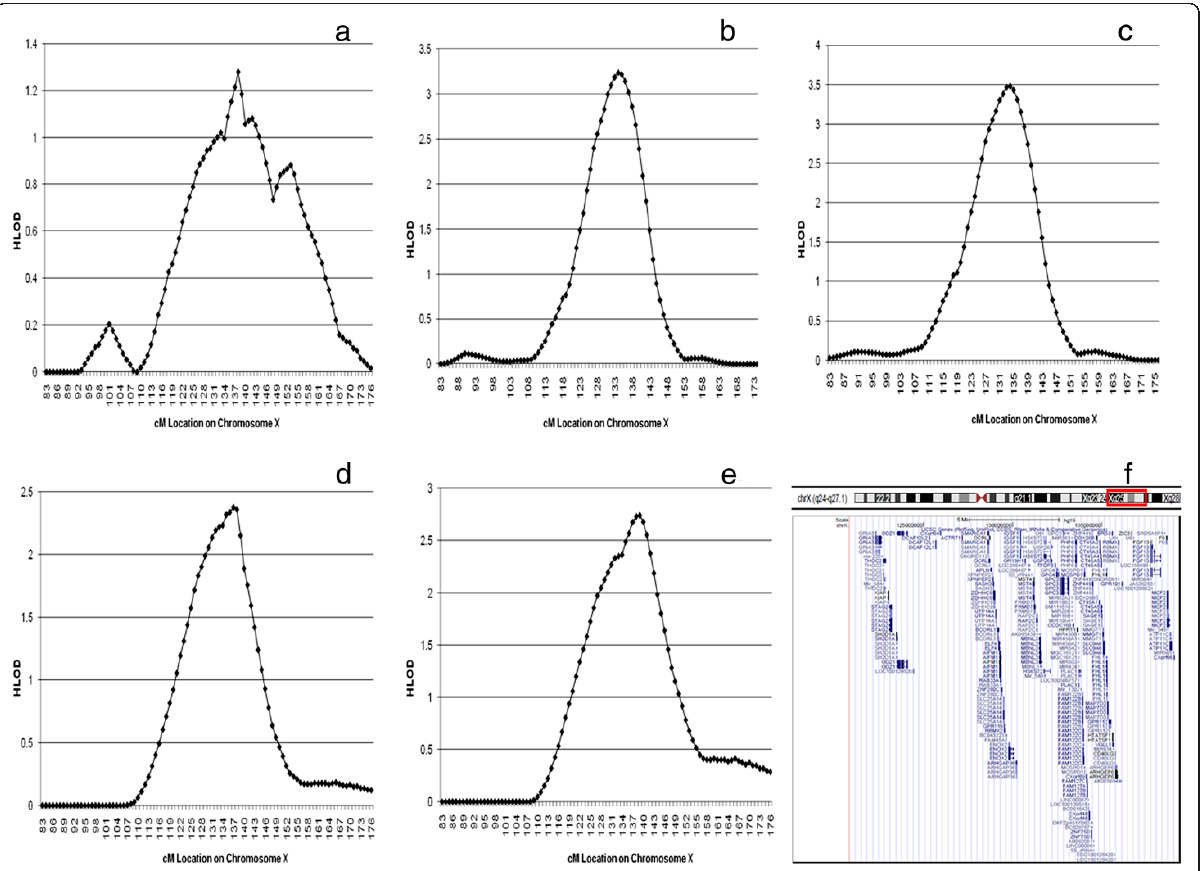
Figure 1 Multipoint HLODs using the GWS marker set and the two-liability class parametric model: a ) using all families, b ) in the subset of families with 2 – 3 affected males and possible male-to-male transmission of prostate cancer, c ) in the subset of families that were not included in the original HPCX linkage paper [3,38] with 2 – 3 affected males and possible male-to-male transmission of prostate cancer, d ) in the subset of families with 2 – 3 affected males that also meet the Carter criteria, e ) in the subset of families with 2 – 3 affected males that also meet the Carter criteria and were not included in the original HPCX linkage paper [38]. Panel f is from the UCSC Genome Browser (http://genome.ucsc.edu) on the Human February 2009 (GRCh37/hg19) Assembly of the human genome and shows the 2-LOD drop linkage interval from the HLOD graph in panel c. This region extends from approximately 122 cM to 144 cM, bounded by markers GATA165B12 and DXS1232, spanning base pair positions 120877968 to